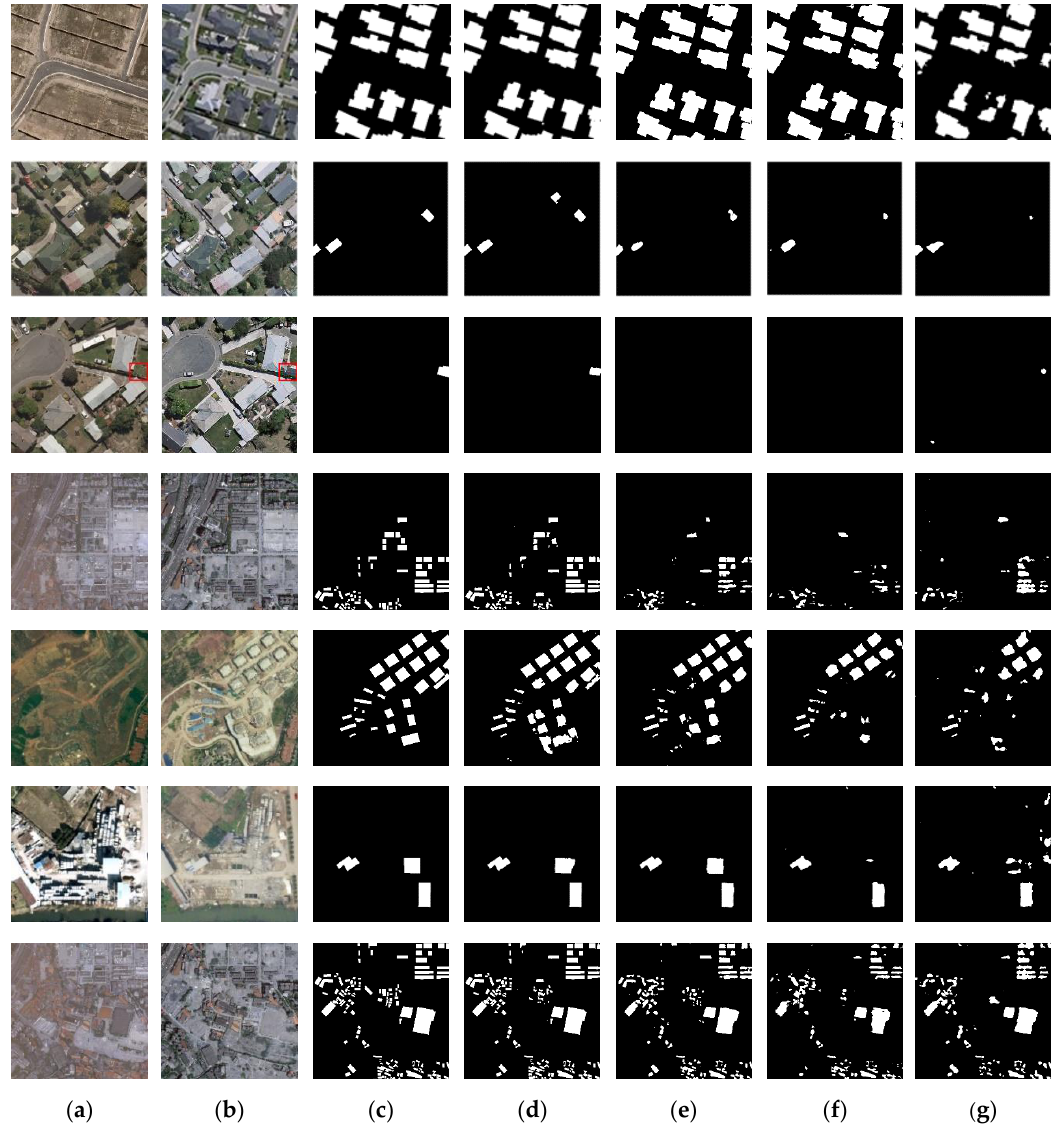
Figure 8. Results by our proposed method, and comparisons with others. ( a ) Before images; ( b ) after images; ( c ) ground truth; ( d ) PGA-SiamNet; ( e ) CSCDNet; ( f ) MSOF; ( g ) FC-Siam-Diff.